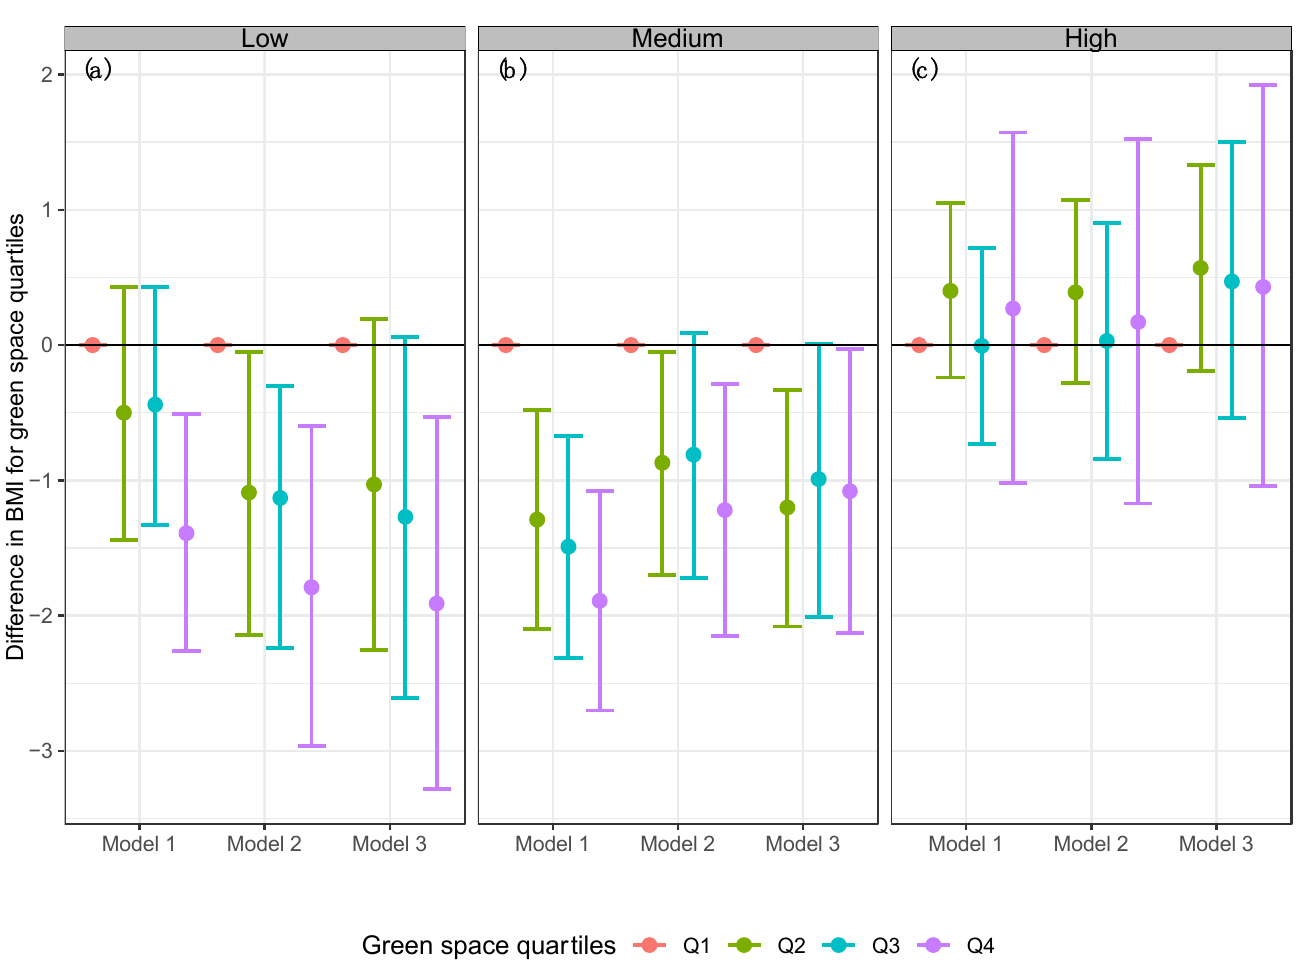
Figure 5. Linear models stratified by socioeconomic status for BMI in the Mexican adult population by the difference quartiles of NDVI. ( a ) Low, ( b ) Medium, ( c ) High. Model 1 = Linear regression model for BMI and NDVI stratified by socioeconomic status. Model 2 = Adjusted linear regression model for BMI, NDVI, age, sex, area, region, and education level stratified by socioeconomic status. Model 3 = Adjusted linear regression model for BMI, NDVI, physical activity, age, sex, area, region, and education level stratified by socioeconomic status.